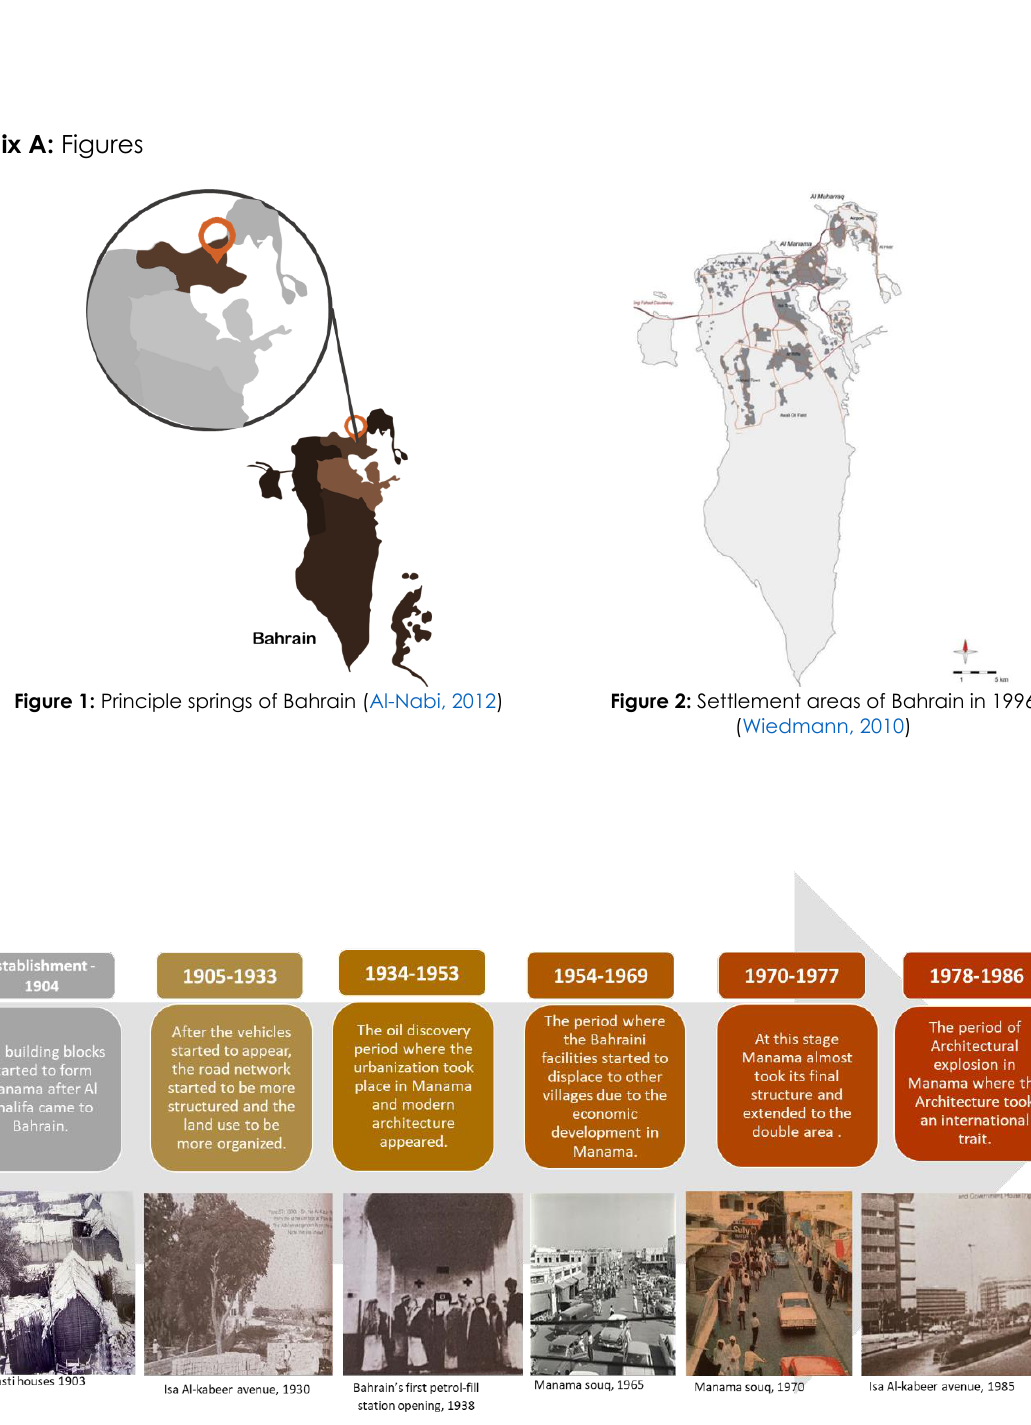
Figure 3: Manama developments timeline, source: